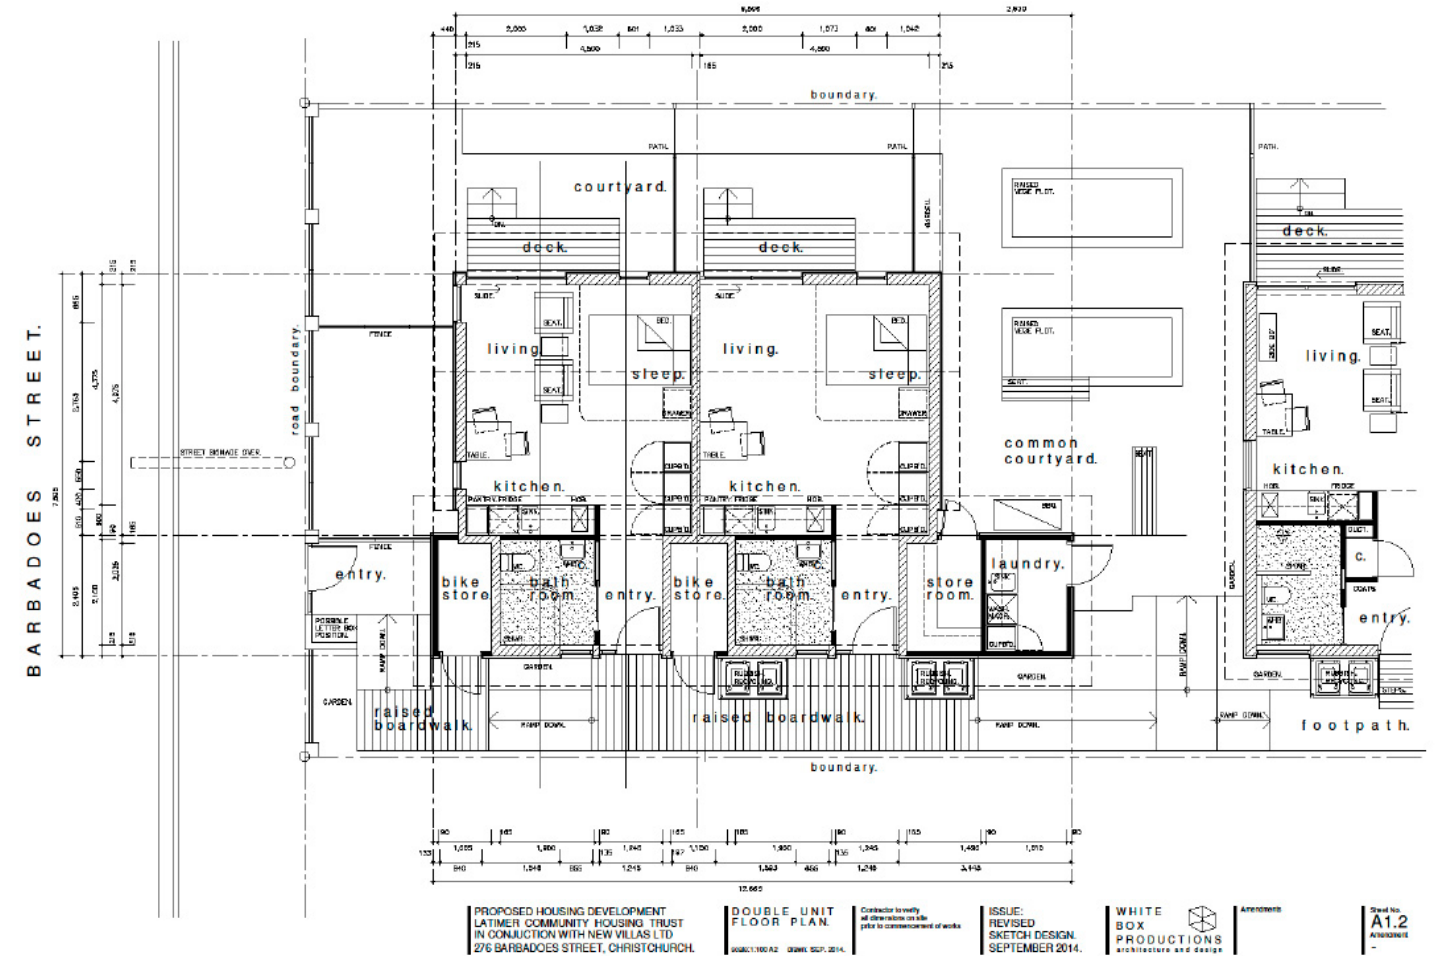
Figure 1. Plan of the model lightweight building A (double-unit house).